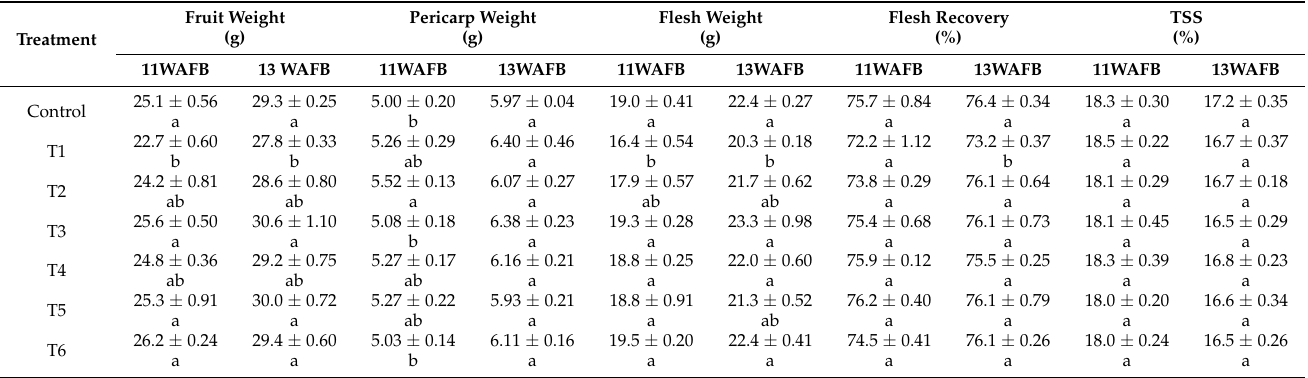
Table 2. Effect of CPPU applied at different stages on fruit quality parameters at commercial ripe (11 WAFB) and overripe (13 WAFB) stages (result of